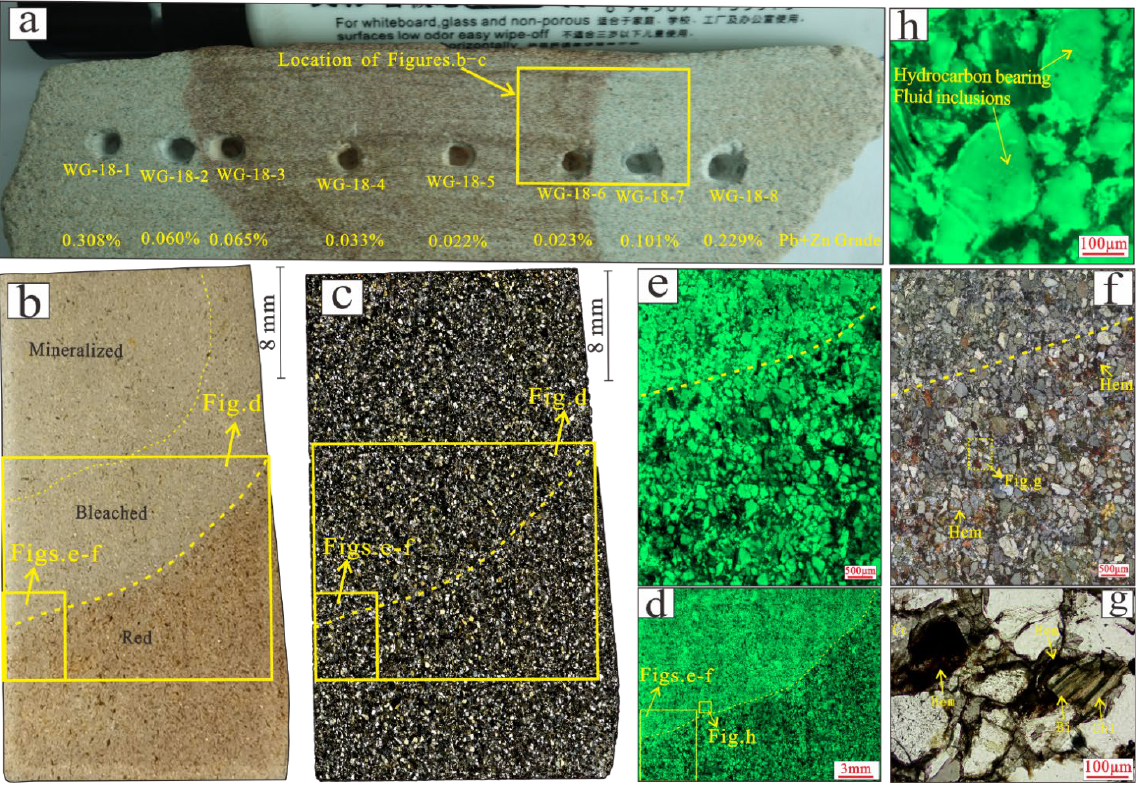
Figure 6. Photographs and photomicrographs of red and bleached sandstone at the same sedimentary layer from the fifth member of the Lower Cretaceous Kezilesu Group in the Uragen Zn–Pb deposit. ( a ) Photograph of WG-18 sample with the micro-drilling holes showing locations of whole-rock geochemical analysis. ( b ) Photograph of WG-18 thin section. ( c ) Panorama of WG-18 thin section under cross-polarized light. ( d , e ) Fluorescence of the interface between red and bleached sandstone under UV light. ( f , g ) Dissolution of IOH and hematite pigment in the bleached sandstone and occurrence of fine-grained hematite in red sandstone under plane-polarized light. ( h ) Hydrocarbon- bearing fluid inclusions in detrital quartz grains of bleached sandstone showing fluorescence under UV light. Mineral abbreviations: Cc, calcite; Bi, biotite; Chl, chlorite; IOH, ferric iron oxide and hy- droxide; Hem, hematite.